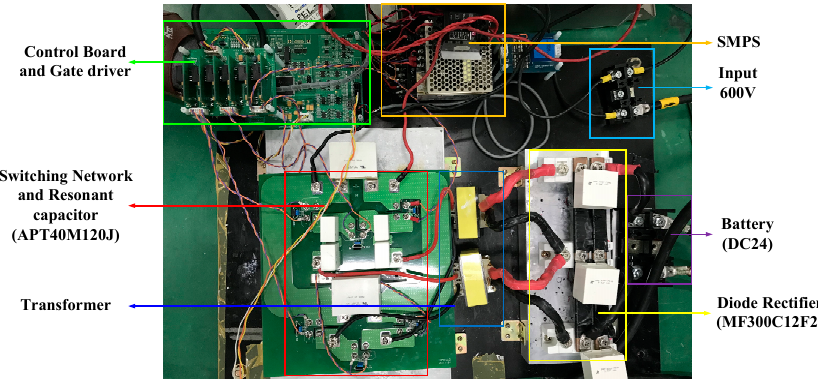
Figure 16. Configuration of the experiment system.